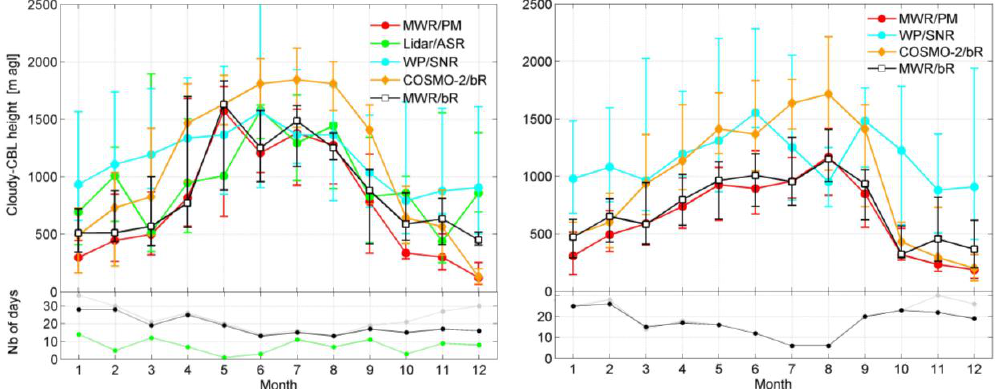
Figure 10. Upper panel: cloudy-CBL height climatology at PAY (left) and SHA (right). Lower panel: number of cloudy-CBL days used to Figure 10: Upper panel: cloudy-CBL height climatology at PAY (left) and SHA (right). calculate the monthly medians. Symbols and colors as in Fig. 9. Lower panel: number of cloudy-CBL days used to calculate the monthly medians. Symbols and colors as in Fig. 9.